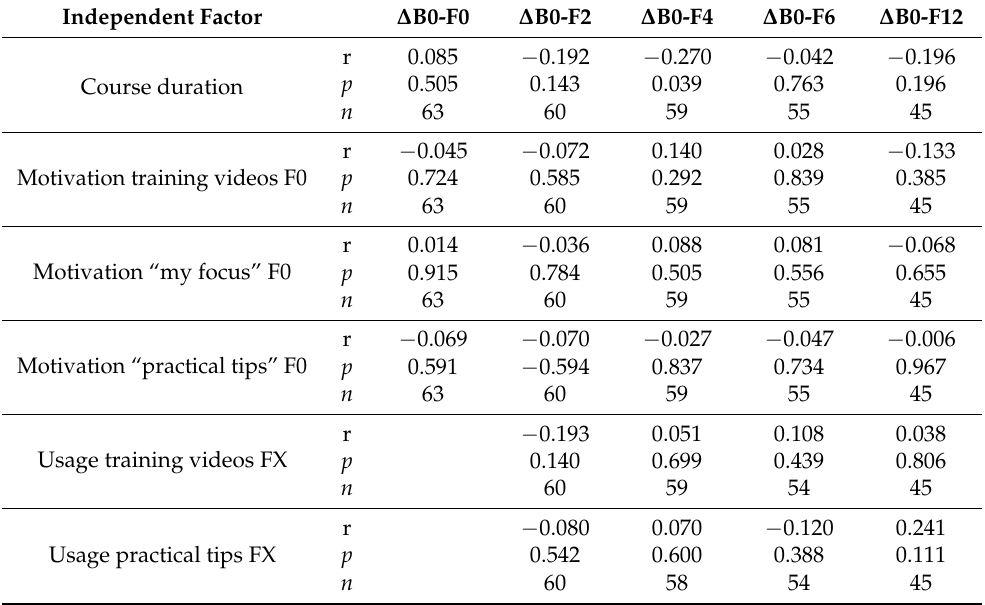
Table A7. Spearman-Rho Test for measuring correlations: Influence of different factors on the effect of the app on the physical activity (MET-minutes per week) between B0 and the following measurement points.